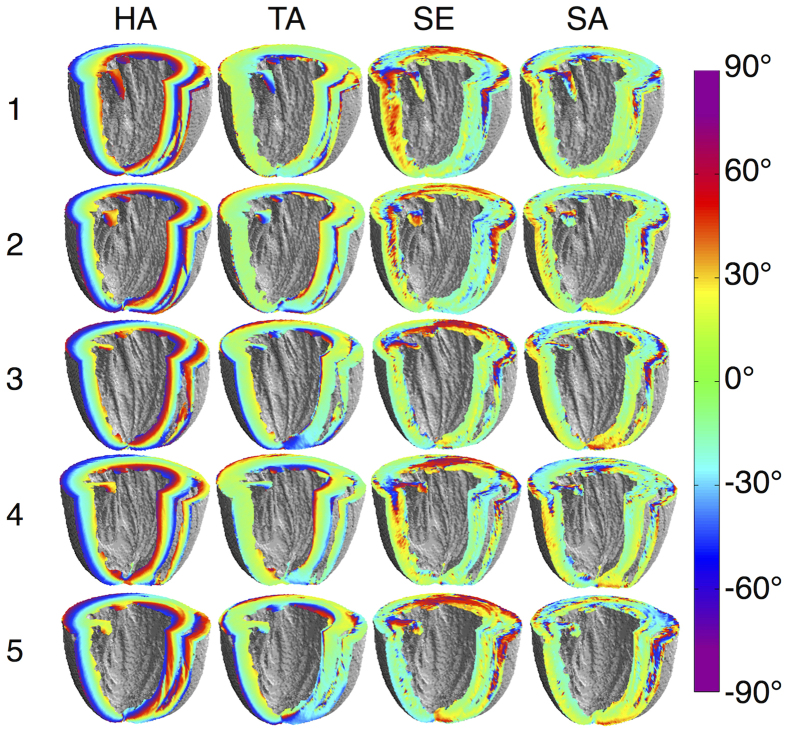
Quantitative angle maps in five healthy ex vivo rat hearts.Both cell and sheetlet orientations are well preserved over all hearts. The transmural transition from left to right helical arrangement of cells is reflected in the helix angle (HA) maps. The transverse angle (TA) remains low in the majority of the myocardium, signifying a primarily circumferential arrangement of cells when projected onto the short-axis plane. The sheet azimuth (SA) is similarly characterised by small angles. This indicates that the projections of the sheetlet-normal onto short-axis plane are predominantly radial. In contrast, the sheet elevation (SE) maps show that the sheetlet-normal varies regionally. In the basal slice as shown for example, SE is near 0° in the LV lateral and septal walls, and varies between approximately 60° to 0° from the LV anterior wall subepicardium to subendocardium. A custom cyclic colour map was used to avoid discontinuities at transitions between −90° and +90°.